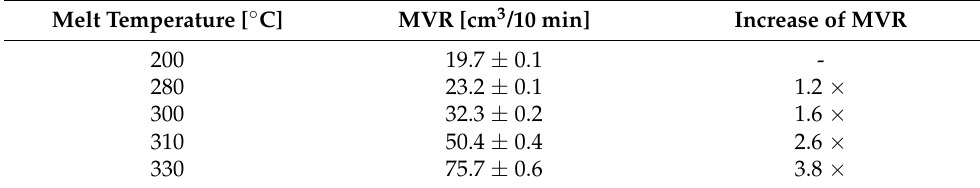
Table 2. Changes in the volume melt flow index (MVR) values depending on melt temperature.